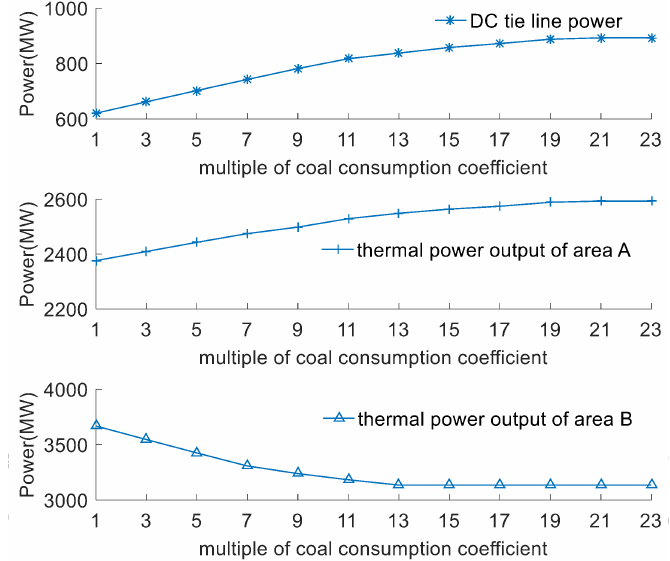
Figure 10. Influence of multiple of coal consumption coefficient of region B relative to region A on power of DC tie line and total output of thermal power units in two areas.